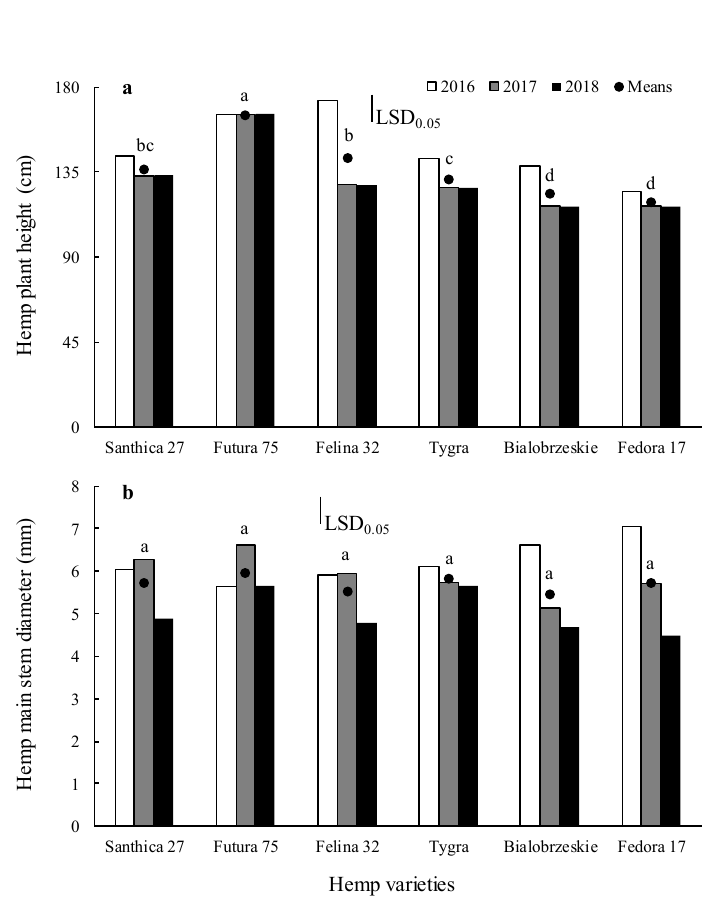
Figure 2. Stem height ( a ) and diameter ( b ) of six industrial hemp varieties. For the year × variety interaction, columns with height differences lower than the LSD height did not significantly differ according to the Fisher’s Protected Least Significant Difference (LSD) test at p = 0.05. For the variety effect, points with the same letter did not significantly differ according to the Fisher’s Protected Least Significant Difference test at p = 0.05. Table 2. Year main effects for the hemp characteristics evaluated during the experiment.